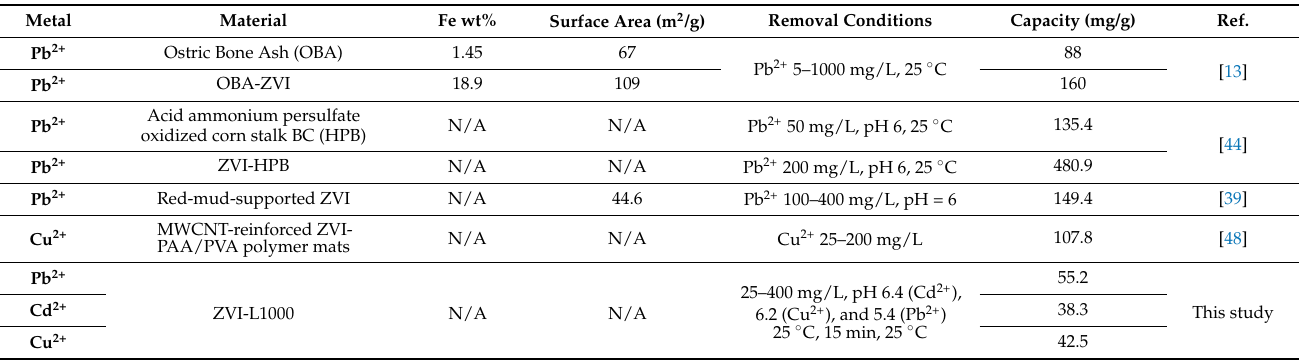
Table 3. Comparison of Cd 2+ , Pb 2+ and Cu 2+ adsorption performance of ZVI-L1000 and lignite with previously developed ZVI